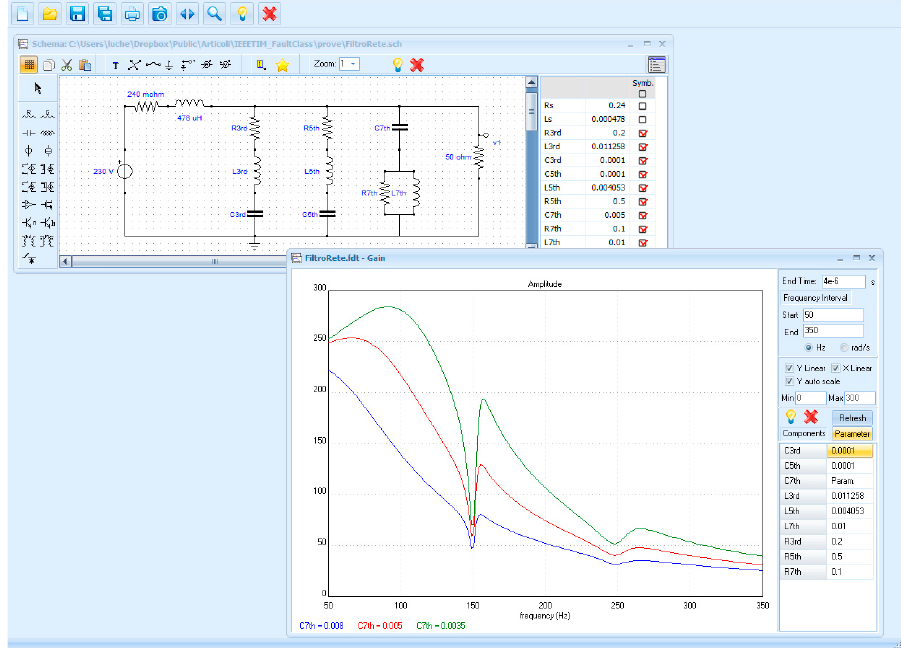
Figure 4. Network filter and magnitude response.